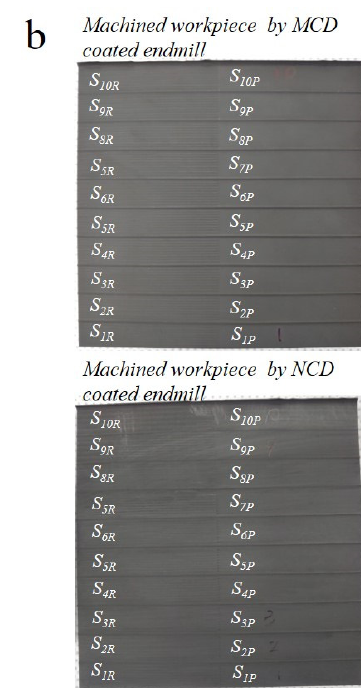
crater wear of the cutting edge, (3) generation of ploughing-type lateral channel as the craters interconnect, (4) increase in lateral channel size of the flank and rake faces and in the deformation of the cutting edge, and (5) occurrence of the delamination of coating layer and substrate damage. Similarly, the wear of the MCD and NCD-coated tools showed the same trend, but the coating was largely delaminated at steps 9 and 4, respec- tively, corresponding to a large difference between coatings, as shown in Figure 10. More- over, no notable damage was observed in the MCD-coated tool, but the NCD-coated tool showed damage of the cutting edge from step 7, as shown in Figure 9s,t.